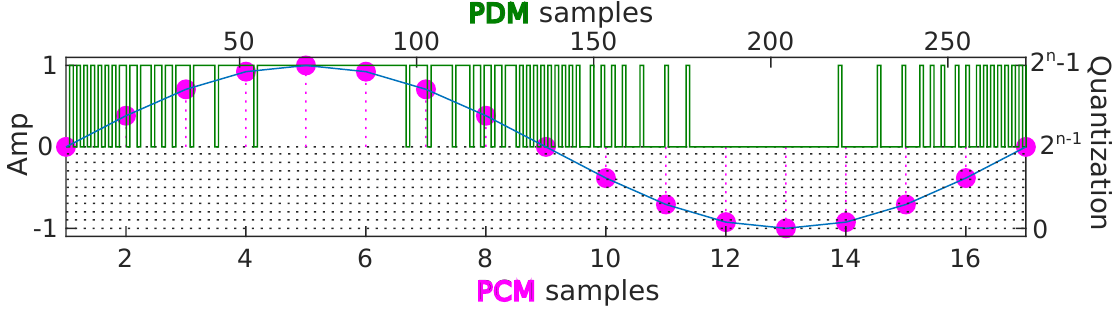
Figure 10. From analog signal to PDM and PCM